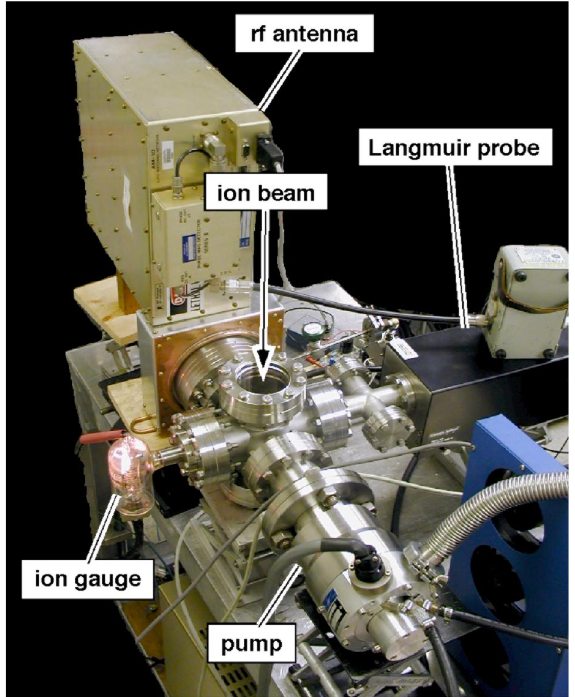
FIG. 30. (Color) PPPL rf argon plasma source before installa- tion. Plasma is created in the six-way cross along the ion- beam